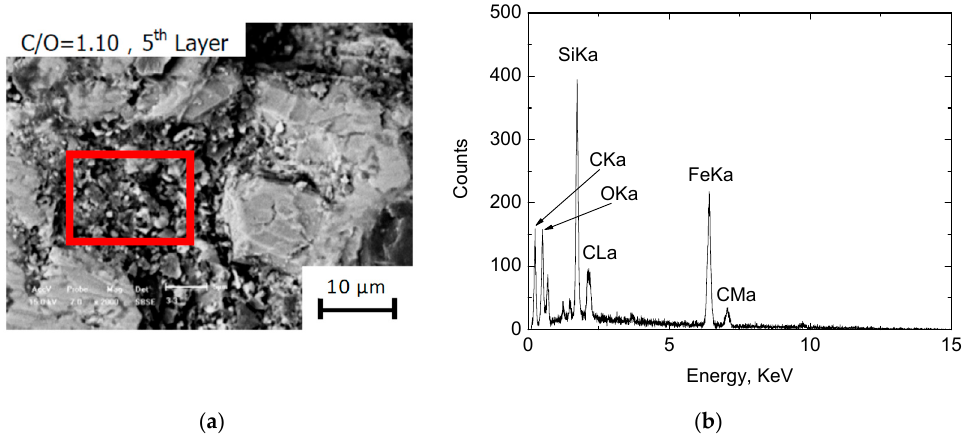
Figure 9. Metallographic and element analysis of the direct reduced iron (DRI) in the 5th layer (C/O = 1.1): ( a ) metallographic picture; ( b ) element analysis.